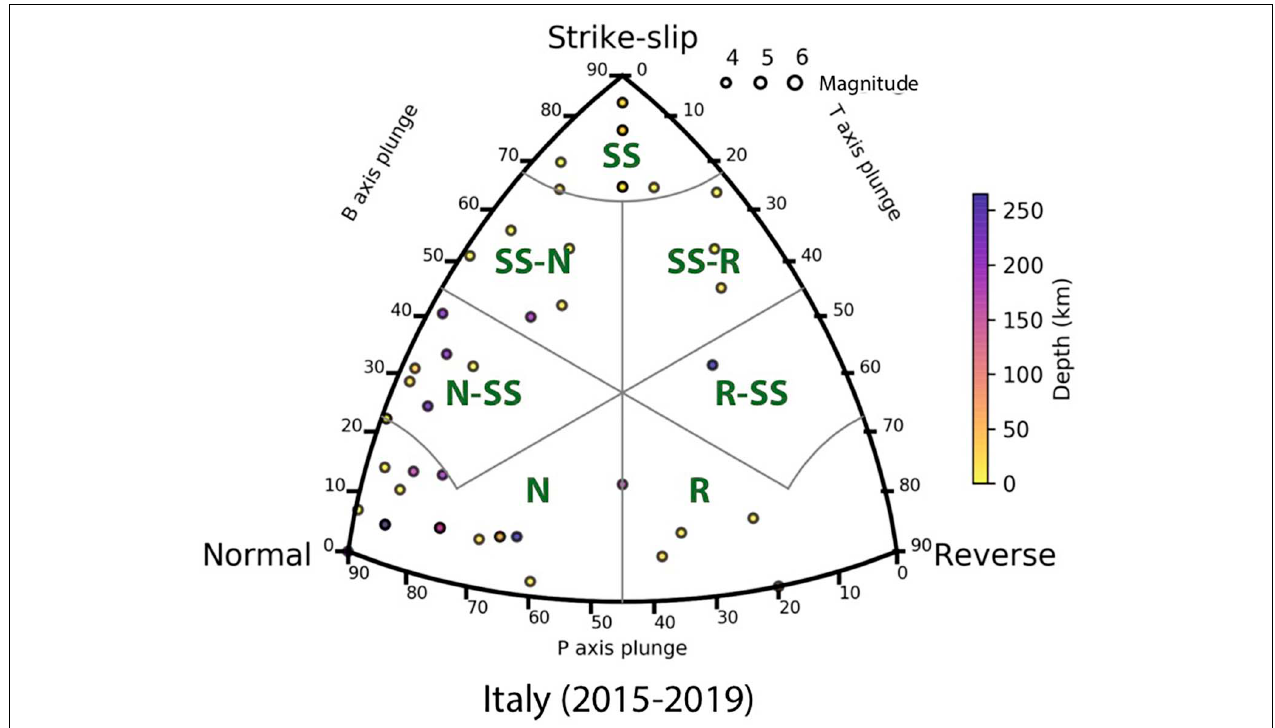
FIGURE 8 | FMC diagram for the classification of focal mechanisms in Italy area. N, normal; N-SS, normal–strike-slip; SS-N, strike-slip–normal; SS, strike-slip; SS-R, strike-slip–reverse; R-SS, reverse–strike-slip; R, reverse. The points are scaled by magnitude and colored by different